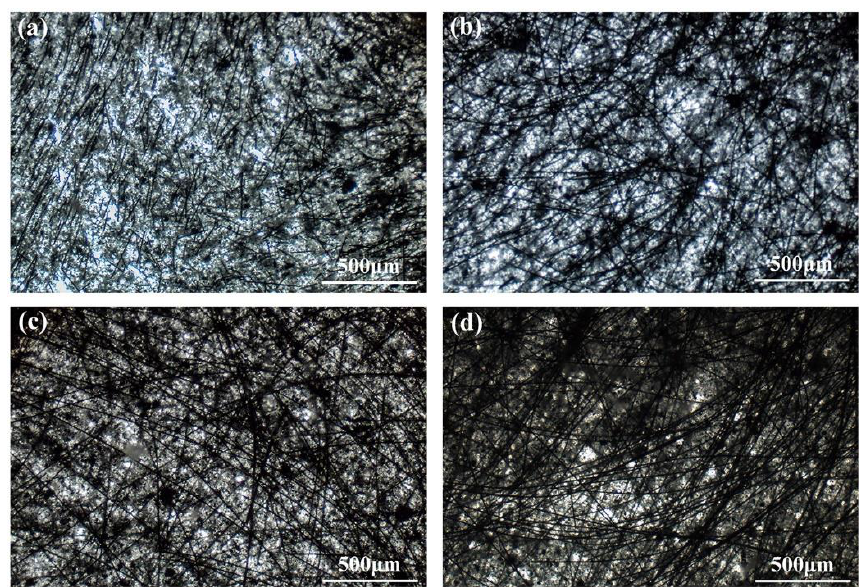
Figure 2. Optical images of unvulcanized samples: ( a ) SF-0.5; ( b ) SF-1; ( c ) SF-3; ( d ) SF-6. Table 2. Mechanical and physical properties of the composites. Samples